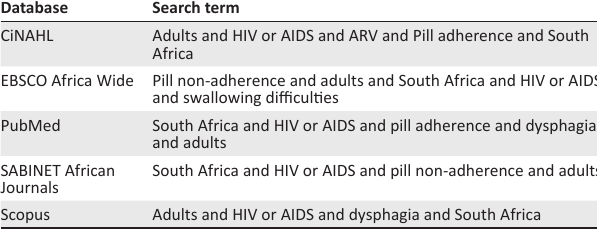
TABLE 1: Search terms and databases included in the scoping